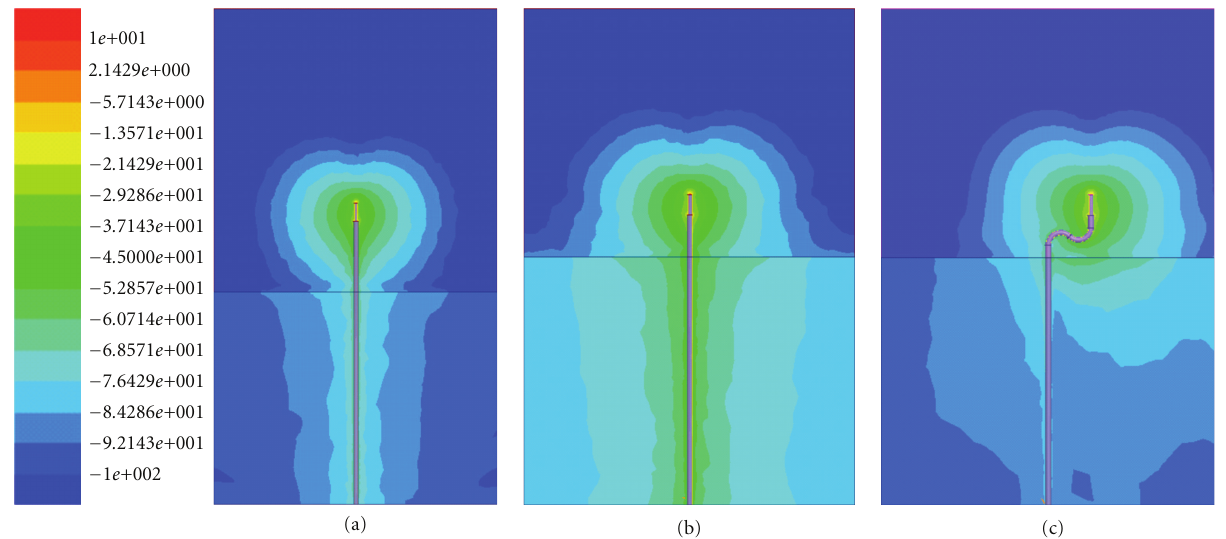
Figure 10: Simulated 900 MHz electric field magnitude distributions (in dB and normalized with respect to the field at the antenna tip) for the (a) long, straight coaxial feed, (b) short, straight coaxial feed, and (c) the longer, serpentine